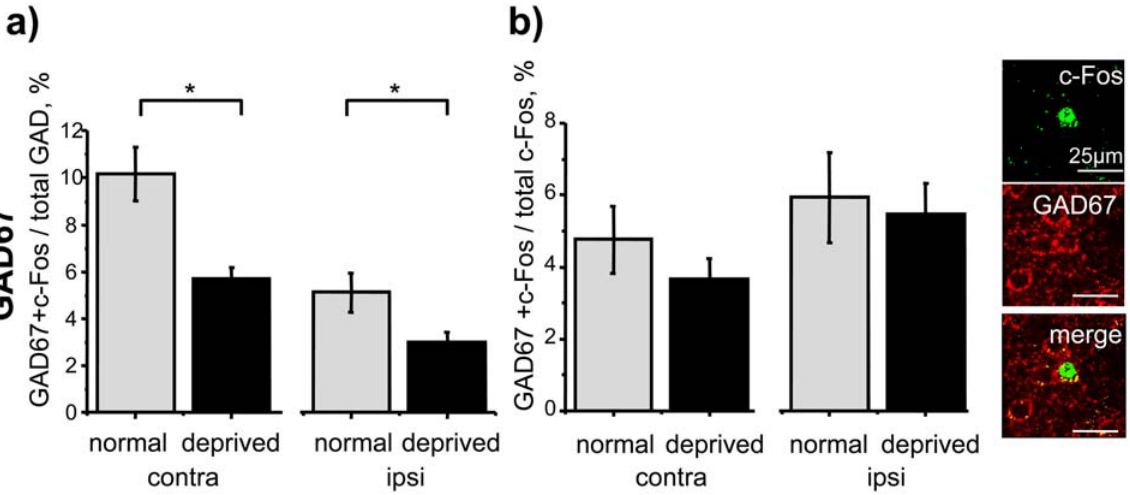
Figure 4. Effect of long-term MD on the whole population of cortical inhibitory interneurons. a) GAD67 cells show a reduction in the D/ M ratio in both hemispheres of MD animals (contra, t test, P=0.002; ipsi, t test, P=0.037, N=10); b) no difference is present in the D/F ratio of GAD67 cells between MD and control animals (contra, t test, P=0.33; ipsi, t test, P=0.76; N=10).